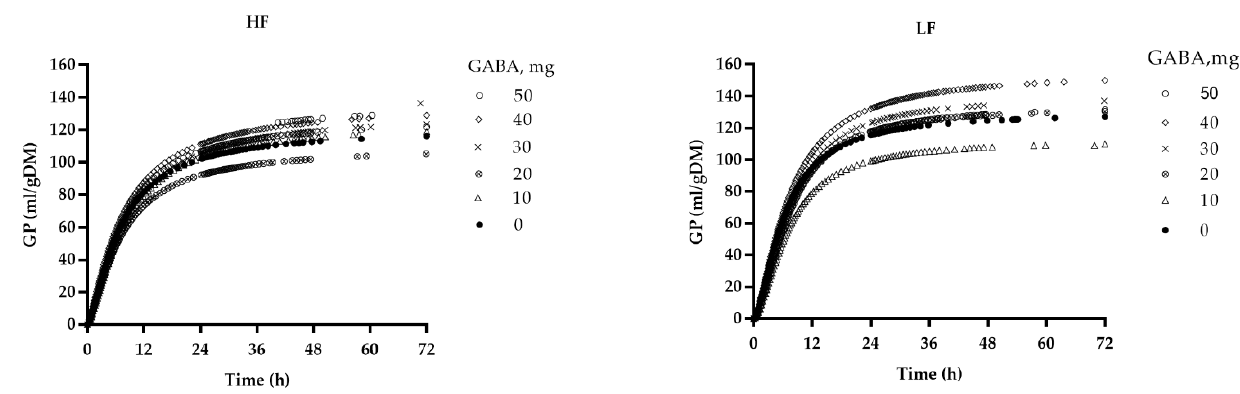
Figure 2. Cumulative gas production (GP) profiles of the high-fiber (HF) and low-fiber (LF) diets incubated with rumen fluids with different dosages of gamma-aminobutyric acid